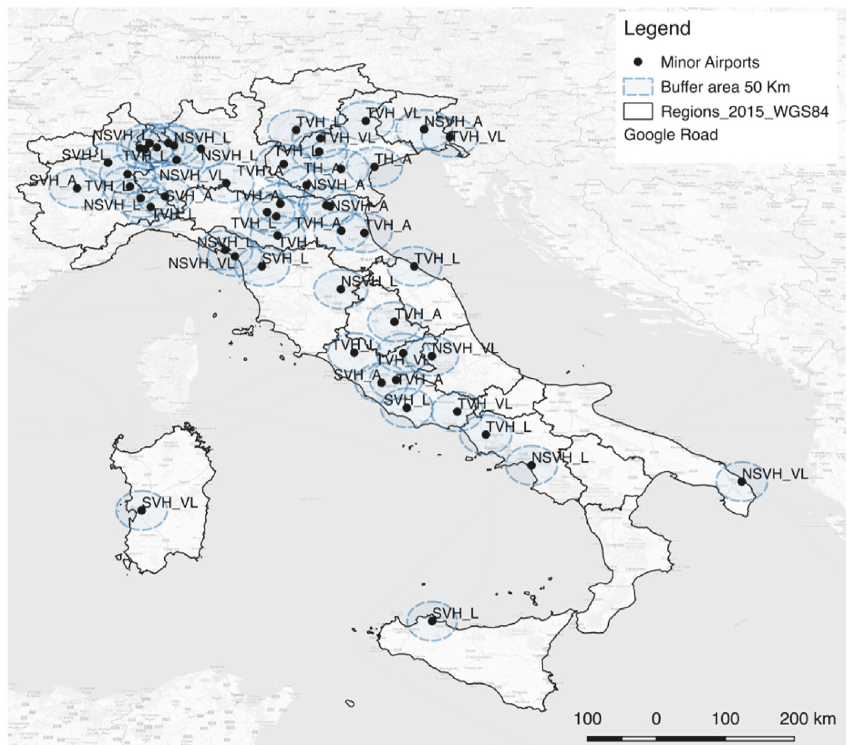
Figure 4: The geographic area of analysis for the JLB: “services